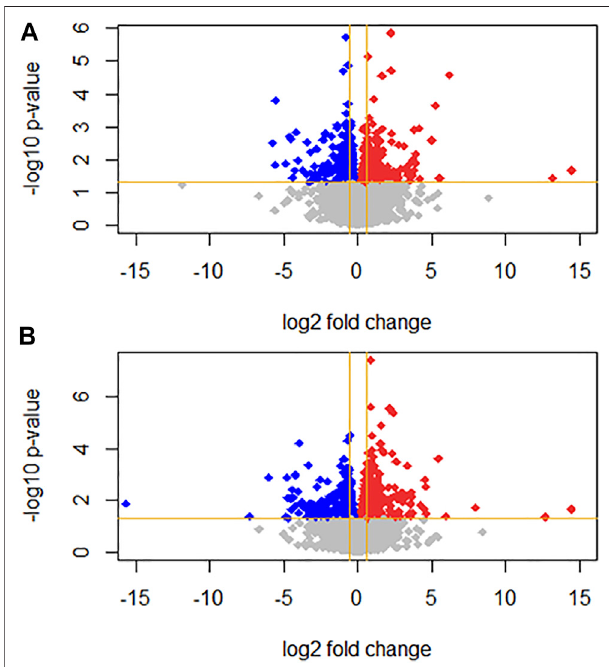
FIGURE 1 | Volcano plots representing gene expression log2 fold change(FC;xaxis)and p -value(yaxis)for (A) 1 nmT3and (B) 10 nmT3.Grey dots represent genes with non-signi fi cant FC; up- and downregulated genes are represented as red and blue dots, respectively.